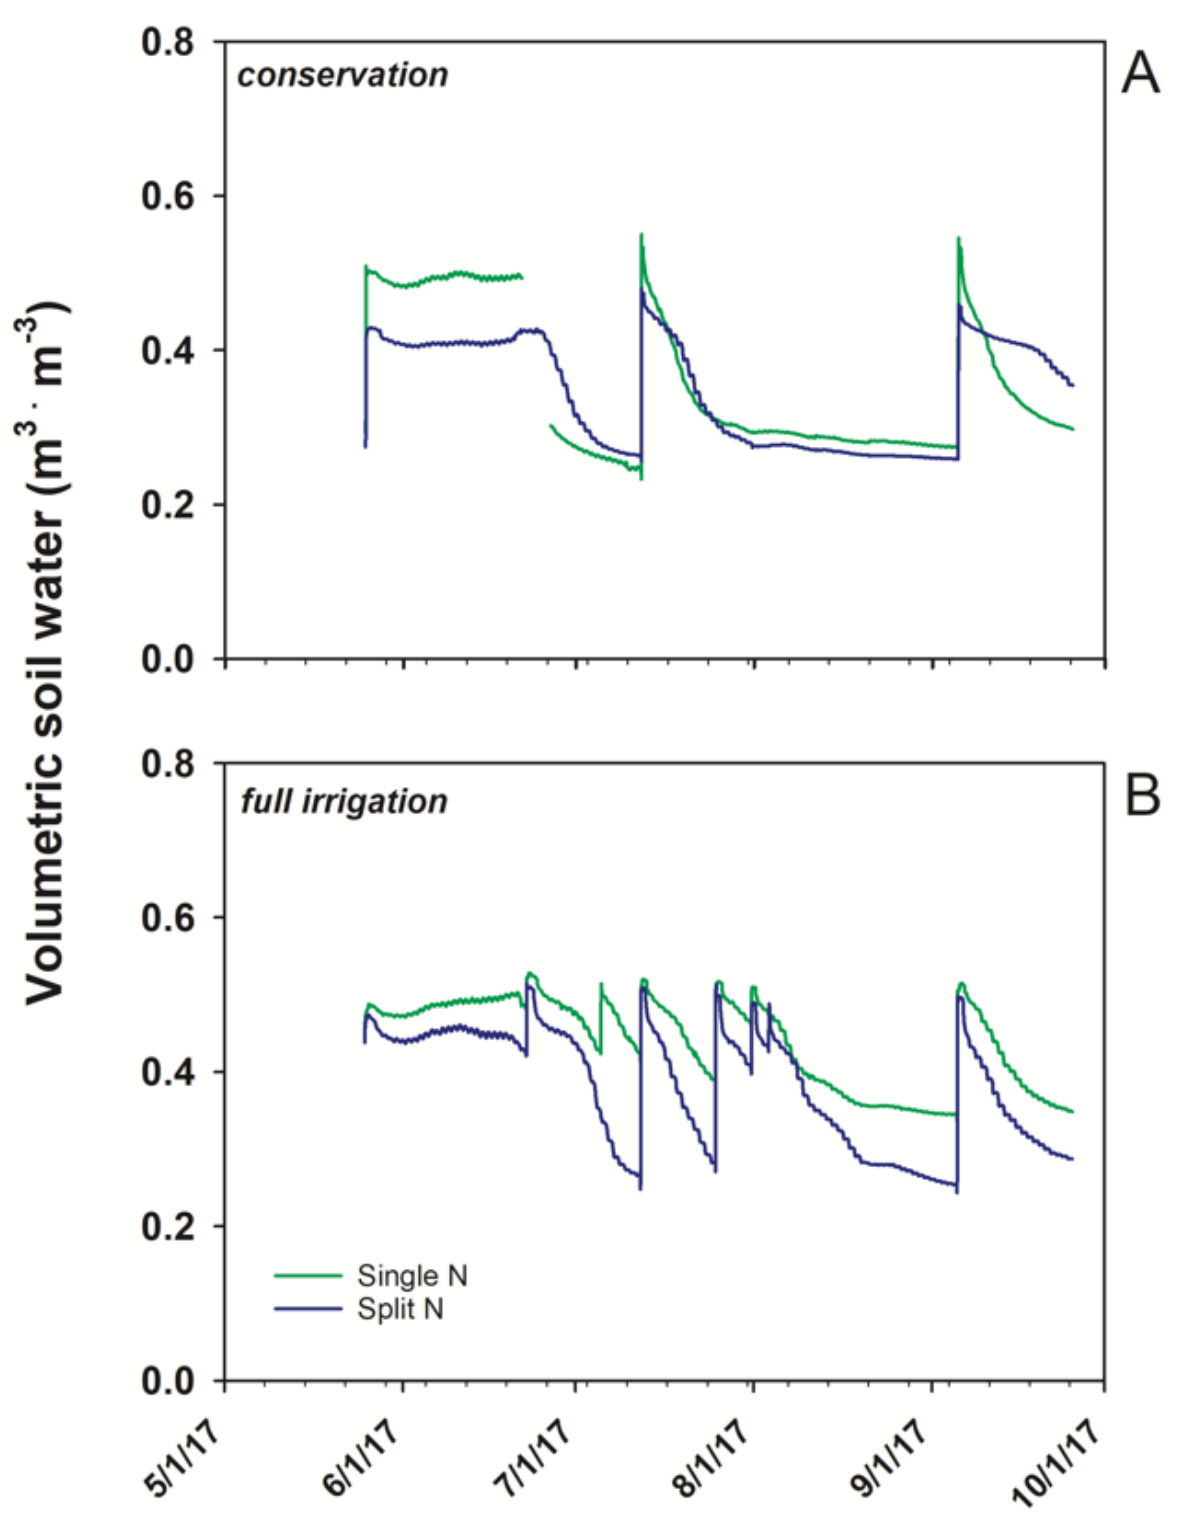
Figure 2. Soil moisture in sorghum fields under ( A ) 30% less irrigation and ( B ) full irrigation. Colored lines indicate fertilizer additions entirely at planting or split between 2 applications.